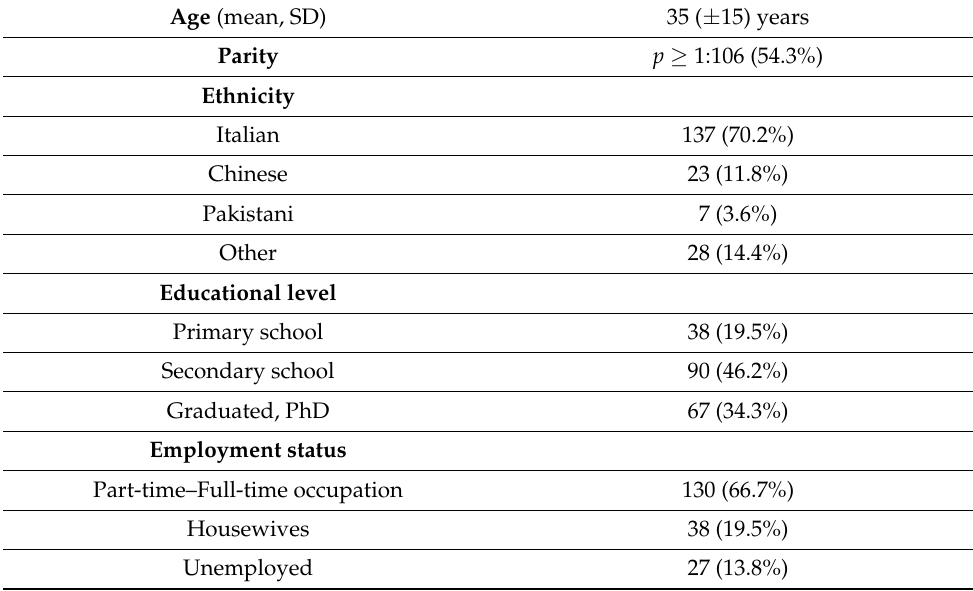
Table 1. Sociodemographic